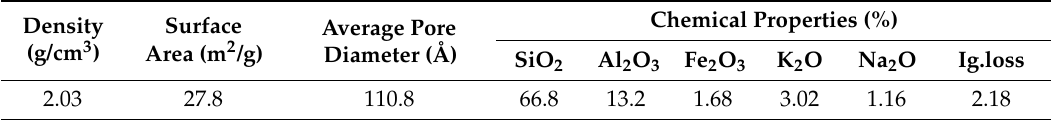
Table 1. Physical and chemical properties of zeolite.